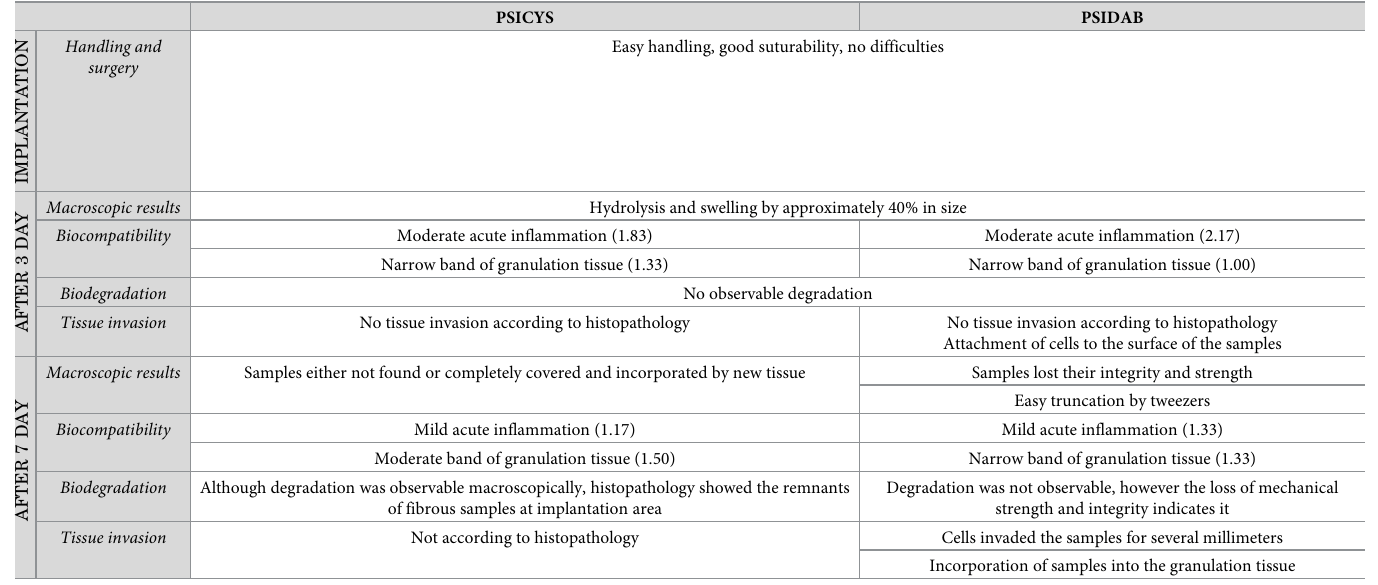
Table 2. Collection of results of in vivo experiments, where at the biocompatibility rows the determined scores can be seen inside the brackets.